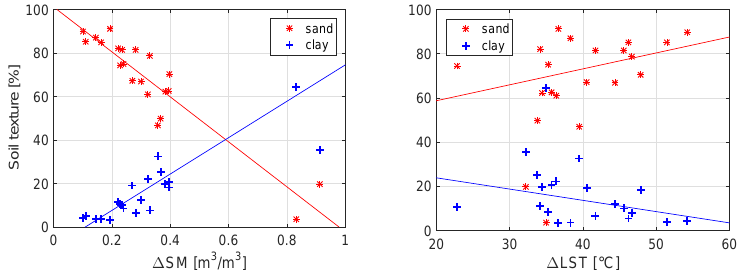
Figure 4. Comparison of in situ SM ( left ) and LST ( right ) dynamic ranges with soil texture: sand content (red asterisks) and clay content (blue crosses). Segments show the linear regression fitting